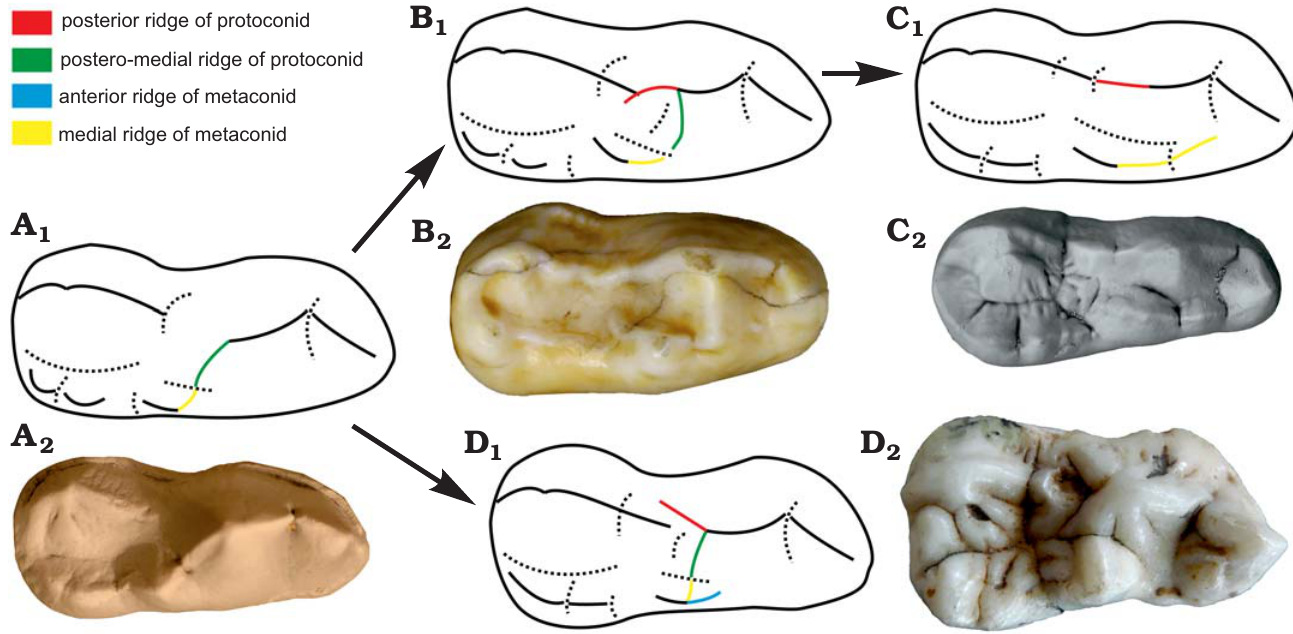
Fig. 9. Illustration showing the evolution of m1 protoconid-metaconid ridges (in occlusal view). A . Stem Ursavus evolutionary grade Ursavus cf. brevirhi- nus (MNHN Ar2399, photo Jan Wagner) from Artenay, France. B . Early Ursus evolutionary grade Ursus malayanus (Raffles, 1821) (AMNH M19154) from Borneo, living. C . Derived Ursus evolutionary grade Ursus deningeri von Reichenau, 1904 (NMM1956/668; photo Jan Wagner, reversed) from Mosbach 2, Germany, early Middle Pleistocene. D . Ailuropoda evolutionary grade: Ailuropoda wulingshanensis Wang and Lin, 1982 (IVPP V13459.266) from Longgu Cave, Jianshi, China, middle Early Pleistocene. A 1 –D 1 , explanatory drawings; A 2 –D 2 , photographs. Not to